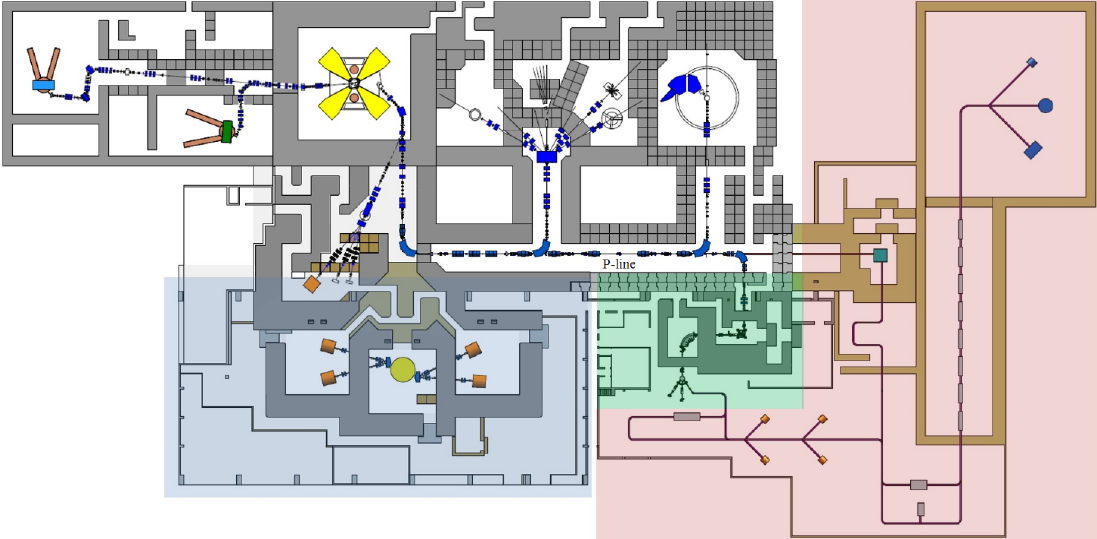
Figure 1. Layout of the cyclotron facility at iThemba LABS, showing ACE Isotopes (shaded blue), Phase 1 of ACE Beams, LERIB (green) and Phase 2 of ACE Beams (pink).